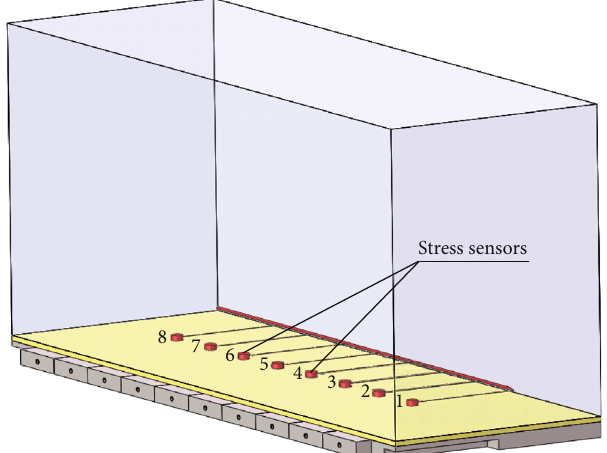
Figure 9: Layout of stress sensors.